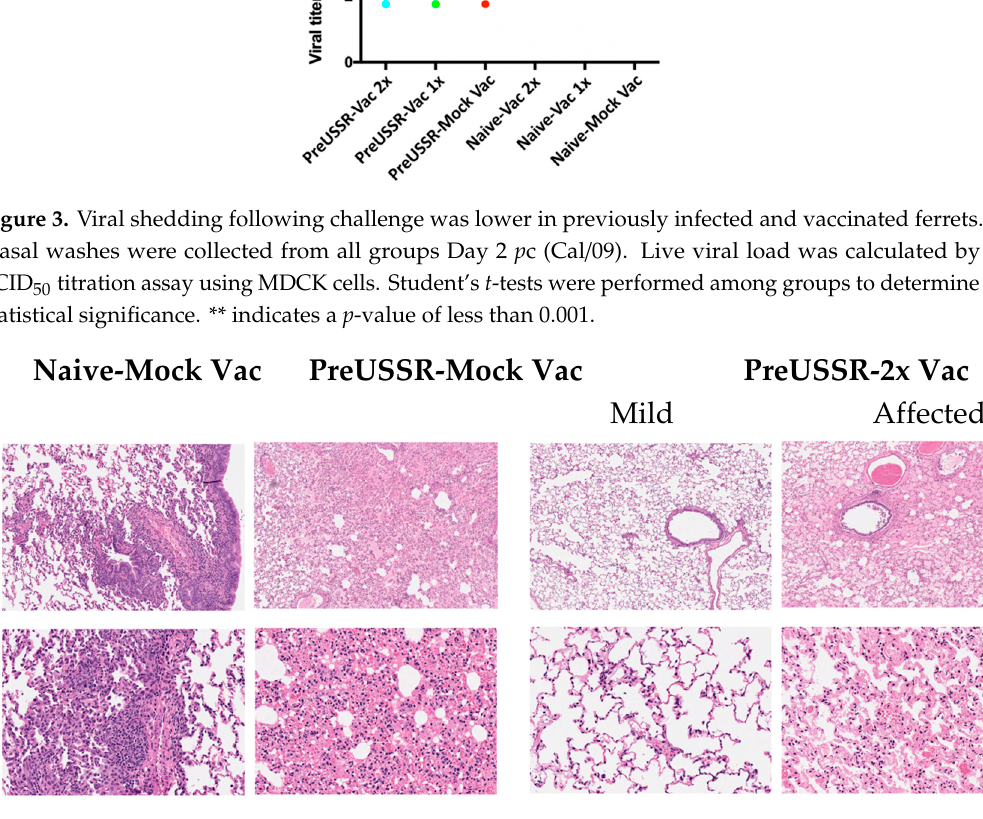
Figure 4. Histopathological analysis shows differential lung pathology on Day 14 post challenge dependent on influenza virus and vaccination history. Respiratory tissue was collected from ferrets Day 14 post challenge and the lungs were processed for histopathological assessment. Tissue morphology was assessed by hematoxylin & eosin staining. Lungs were analyzed by microscopy from at least three ferrets per group. Images were captured as described and representative images from the groups Naïve-Mock Vac; PreUSSR-Mock Vac; and PreUSSR-2x Vac are shown. High resolution scans were performed using an Aperio ScanScope XT (Leica Biosystems, Concord, Canada) at 40 × magnification. Images of the scans were captured using the HALO program from UHN AOMF (Advanced Optical Microscopy Facility, Toronto, Canada) at 5 × (low) or 20 × (high) magnification of the scan.